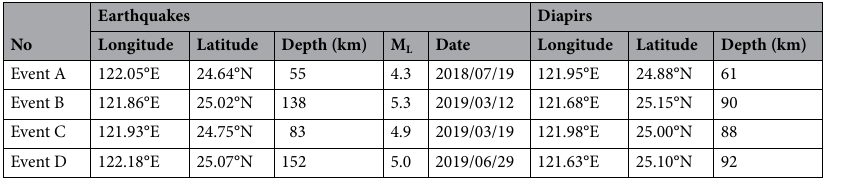
Table 1. Earthquake and diapir